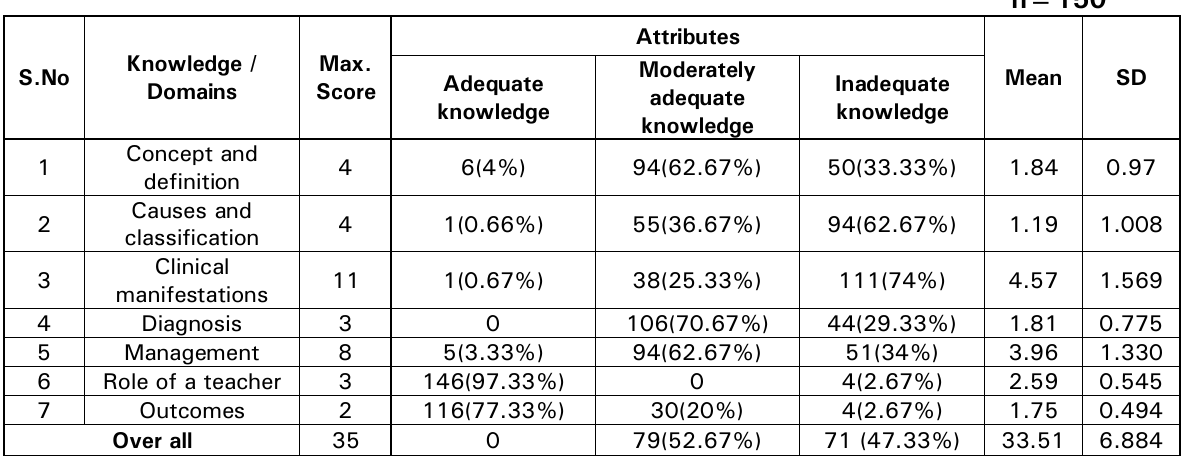
Table 1 Depicts the frequency and percentage distribution of primary school teachers according to their demographic variables. Maximum numbers Table 2: Knowledge Scores of Primary School Teachers on Knowledge Questionnaire